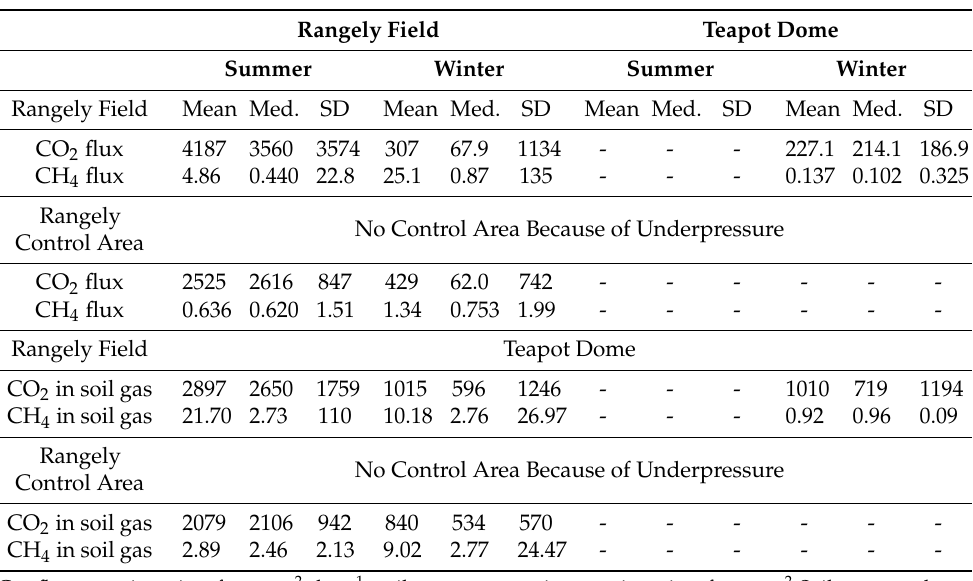
Table 2. Gas flux and soil gas concentrations at Rangely and Teapot Dome 1,2